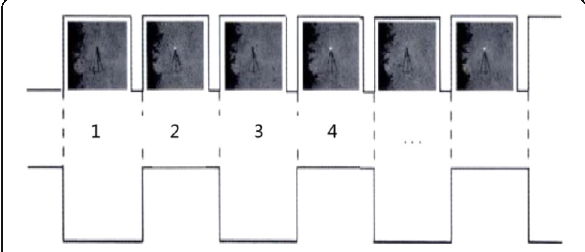
Fig. 13 The combination of active and passive image acquisition